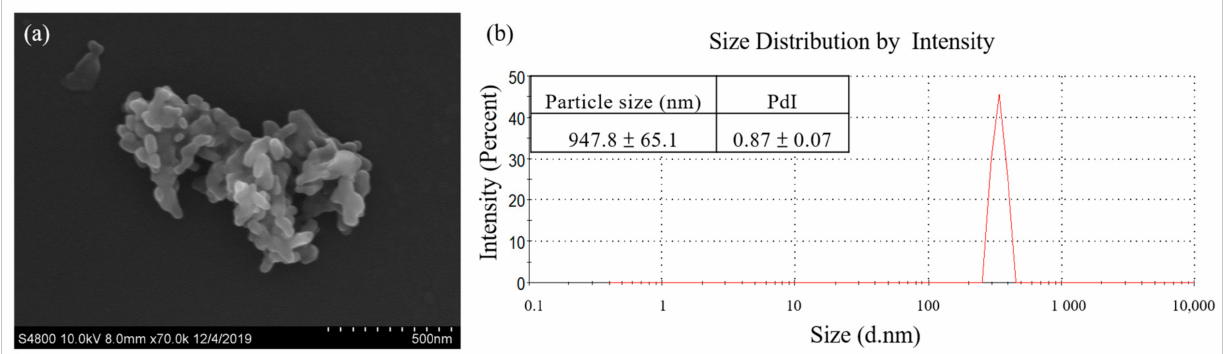
Figure 3. Morphology and particle size of Cur-SHAP. ( a ) SEM images of Cur-SHAP. The images reveal an open and interconnected porous structure. ( b ) Size distribution of Cur-SHAP analyzed by DLS. The results indicate that the Cur- SHAP particle size ranged from 900 to 1000